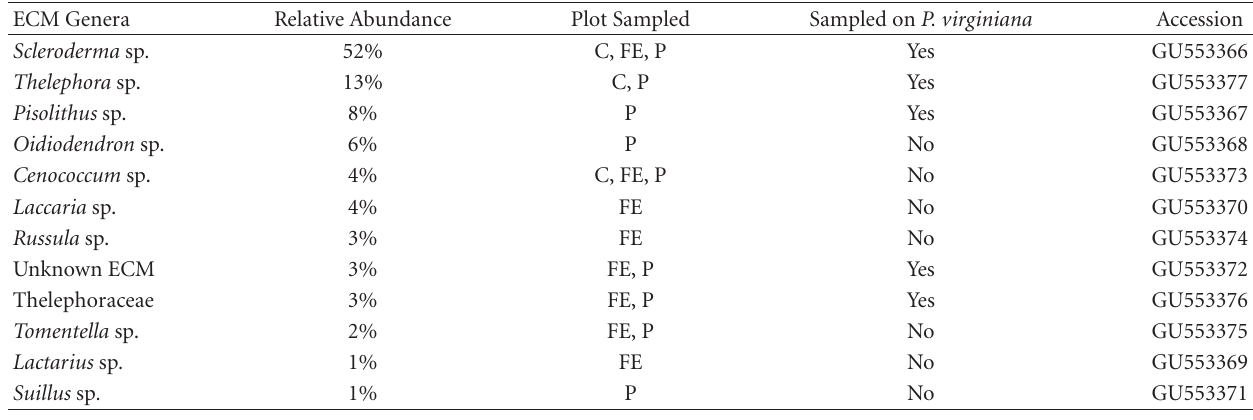
Table 3: Species sampled from pure American and backcrossed chestnut after two field seasons. Species are recorded with their percent abundance, habitat type plot from where they were sampled (C: center, FE: forest edge, and P: pine plot), whether they were found on the roots of adjacent P. virginiana and published GenBank accessions.